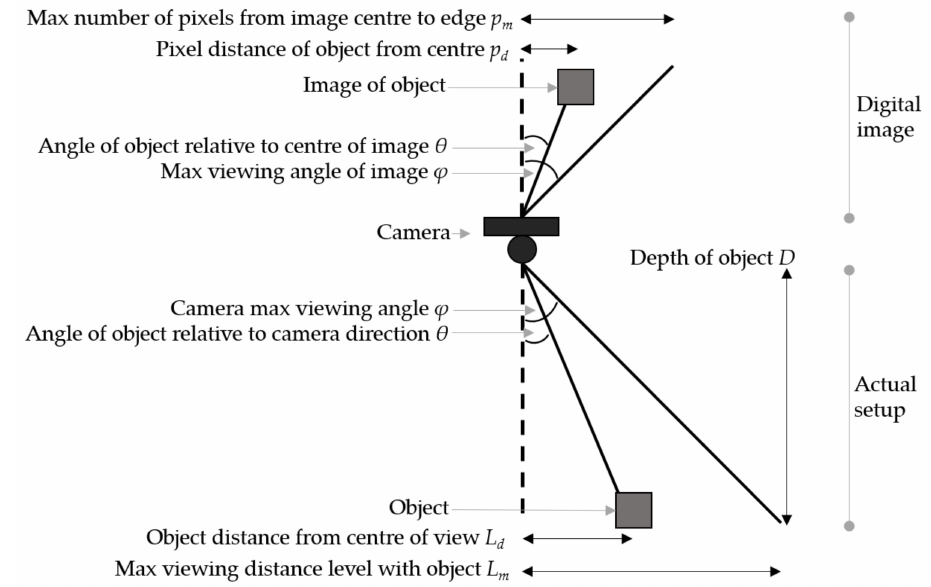
Figure 12. Diagram showing how the 3D position of an object can be calculated from the object’s depth, and its relative pixel position in an image. The angle of the object from the camera’s centre view is equivalent to the pixel angle of the object in the image. After performing two calculations for both the object’s width and height, its position can be estimated.